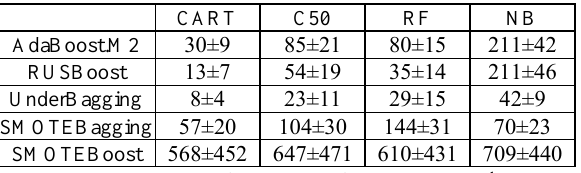
Table 2. Training time for the classifiers in seconds (mean ± standard deviation)